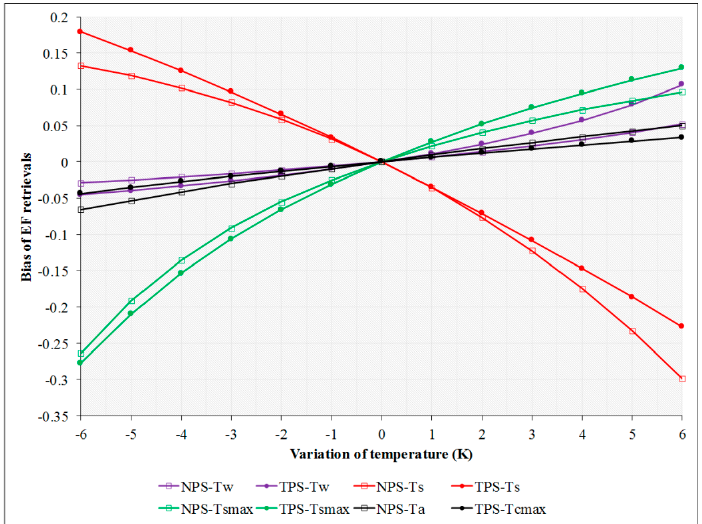
Figure 13. Sensitivity of EF retrievals to the variation of temperature related parameters.